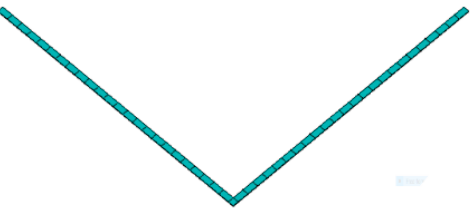
Figure 33. Modeling of CFRP laminate adjacent to columns (column laminate).